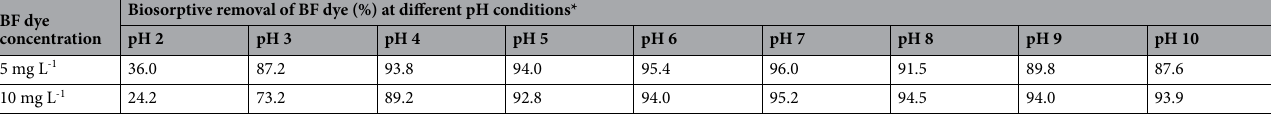
Table 2. Biosorptive removal of BF dye by Gel@GO-F-ZrSiO 4 @Gel at different pHs. *Values are based on triplicate analysis with ± 0.2–0.6%.